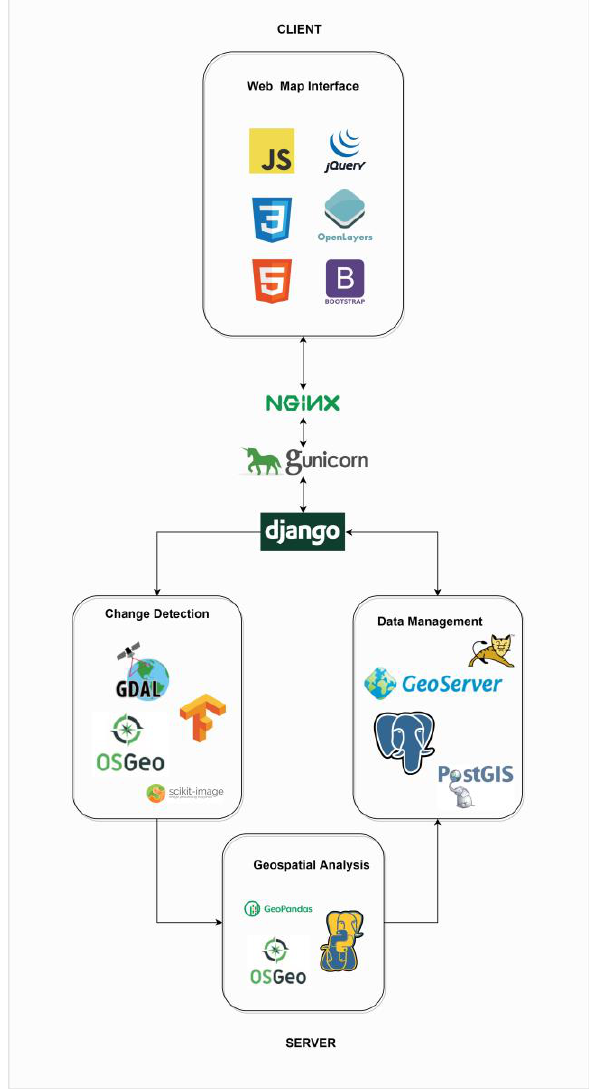
Figure 2. The system components and technologies